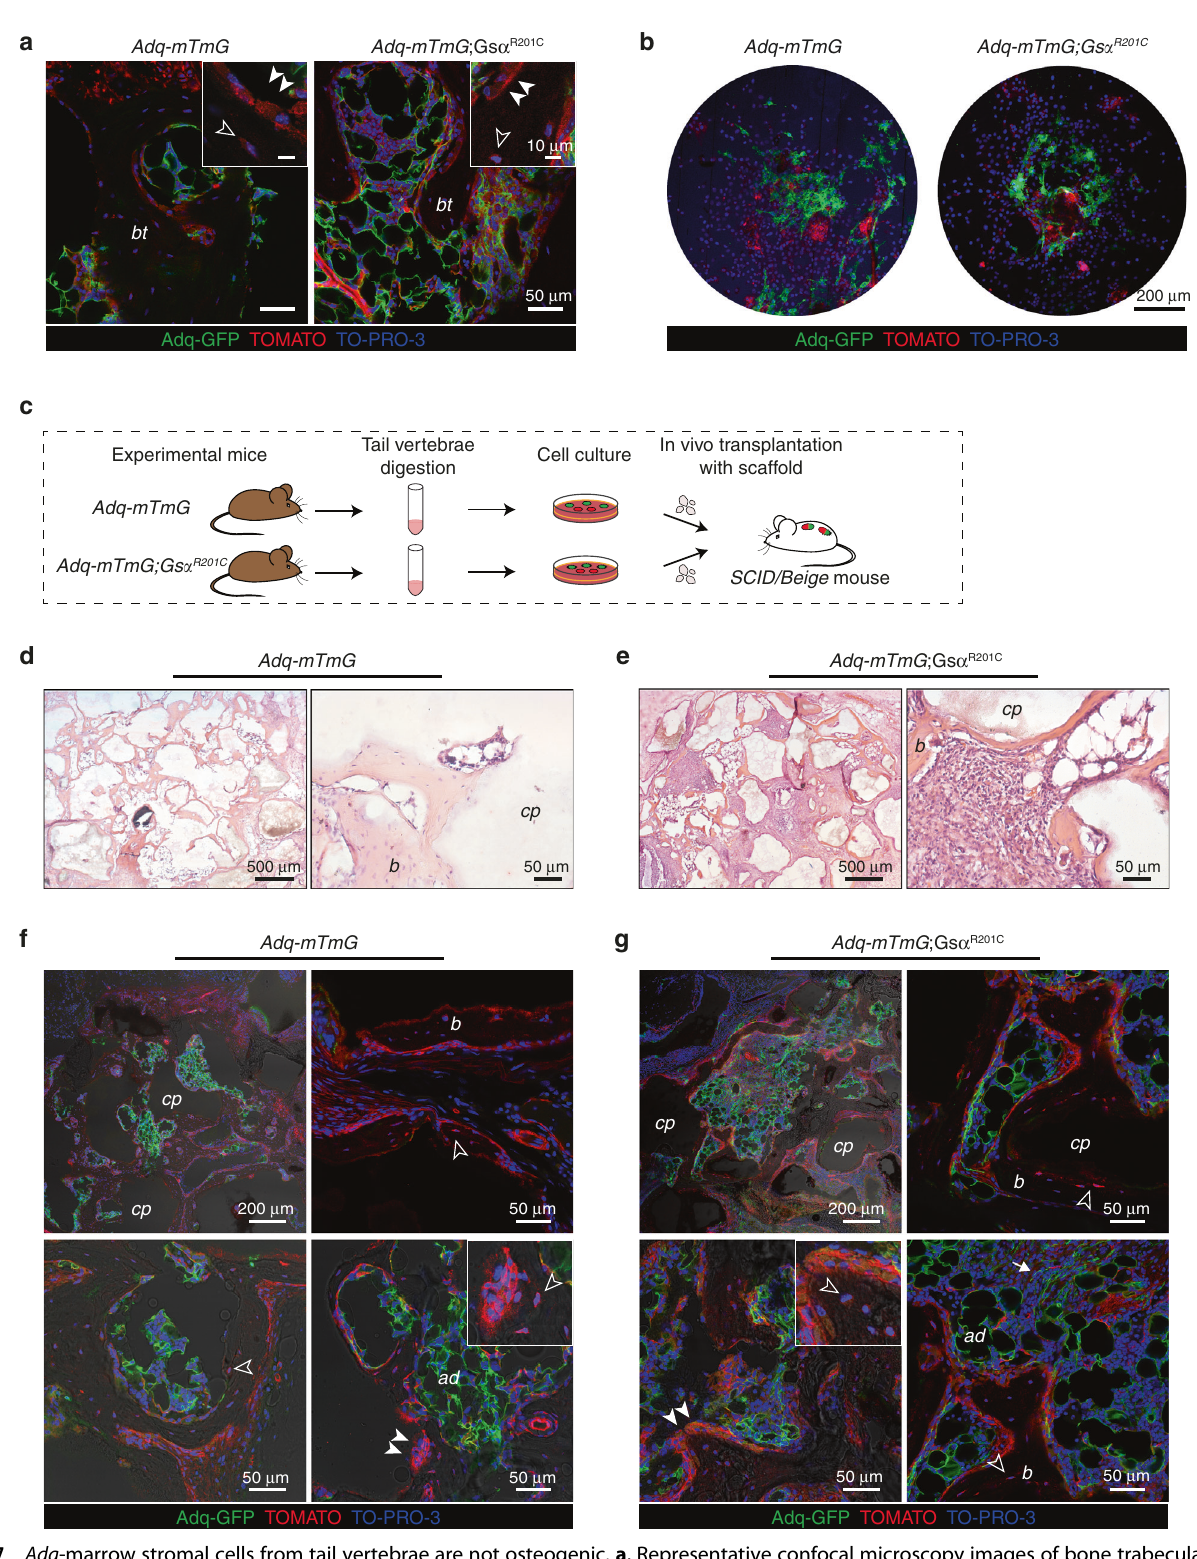
Fig. 7 Adq -marrow stromal cells from tail vertebrae are not osteogenic. a , Representative confocal microscopy images of bone trabeculae ( bt ) in the tail vertebrae of Adq-mTmG and Adq-mTmG ; Gs α R201C mice showing only Tomato positive osteoblasts ( arrowhead ) and osteocytes ( hollow arrowhead ). b GFP-labeled adherent cells in BMSC cultures isolated from tail vertebrae of 2-month-old mice. c Experimental design for the heterotopic transplantation of bone marrow stromal cells isolated from tail vertebrae. d , e Representative transmitted light microscopy images of Adq-mTmG and Adq-mTmG;Gs α R201C transplants showing newly formed bone on the surfaces of carrier particles and inter-particle spaces occupied by bone marrow and adipocytes. f , g Representative confocal microscopy images of the same transplants showing GFP labeling in adipocytes ( ad ) and stromal cells ( arrow ) within the inter-particle spaces. Only Tomato positive osteoblasts ( arrowhead ) and osteocytes ( hollow arrowhead ) were found in these transplants. b Bone, cp Carrier